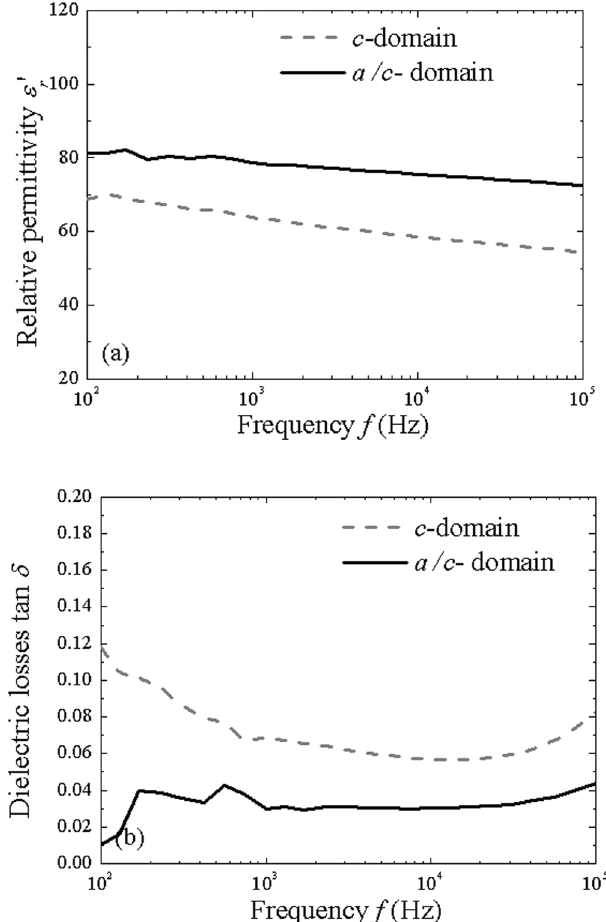
Figure 3. Dielectric properties ( a ) ε ′